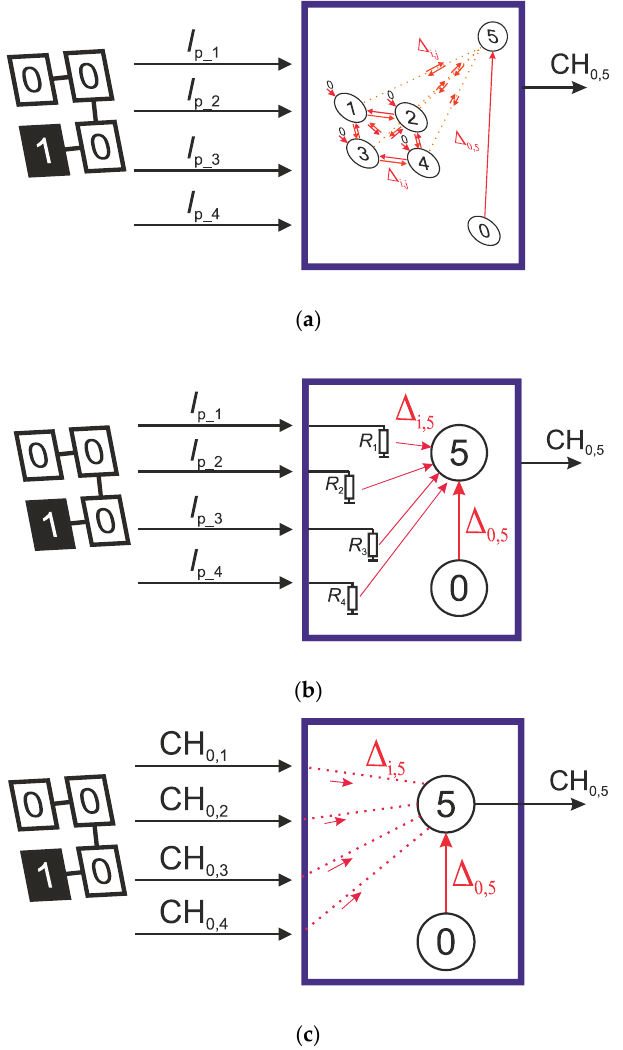
Figure 19. ( a ) A fully connected network, where the input signal is determined by oscillator currents I p and the output signal is determined by synchronization value CH. ( b ) A simplified two-oscillator circuit, where the input signal is given by the currents of thermistors. ( c ) A simplified two-oscillator circuit, where the input and output signals consist of signals of a certain synchronization.